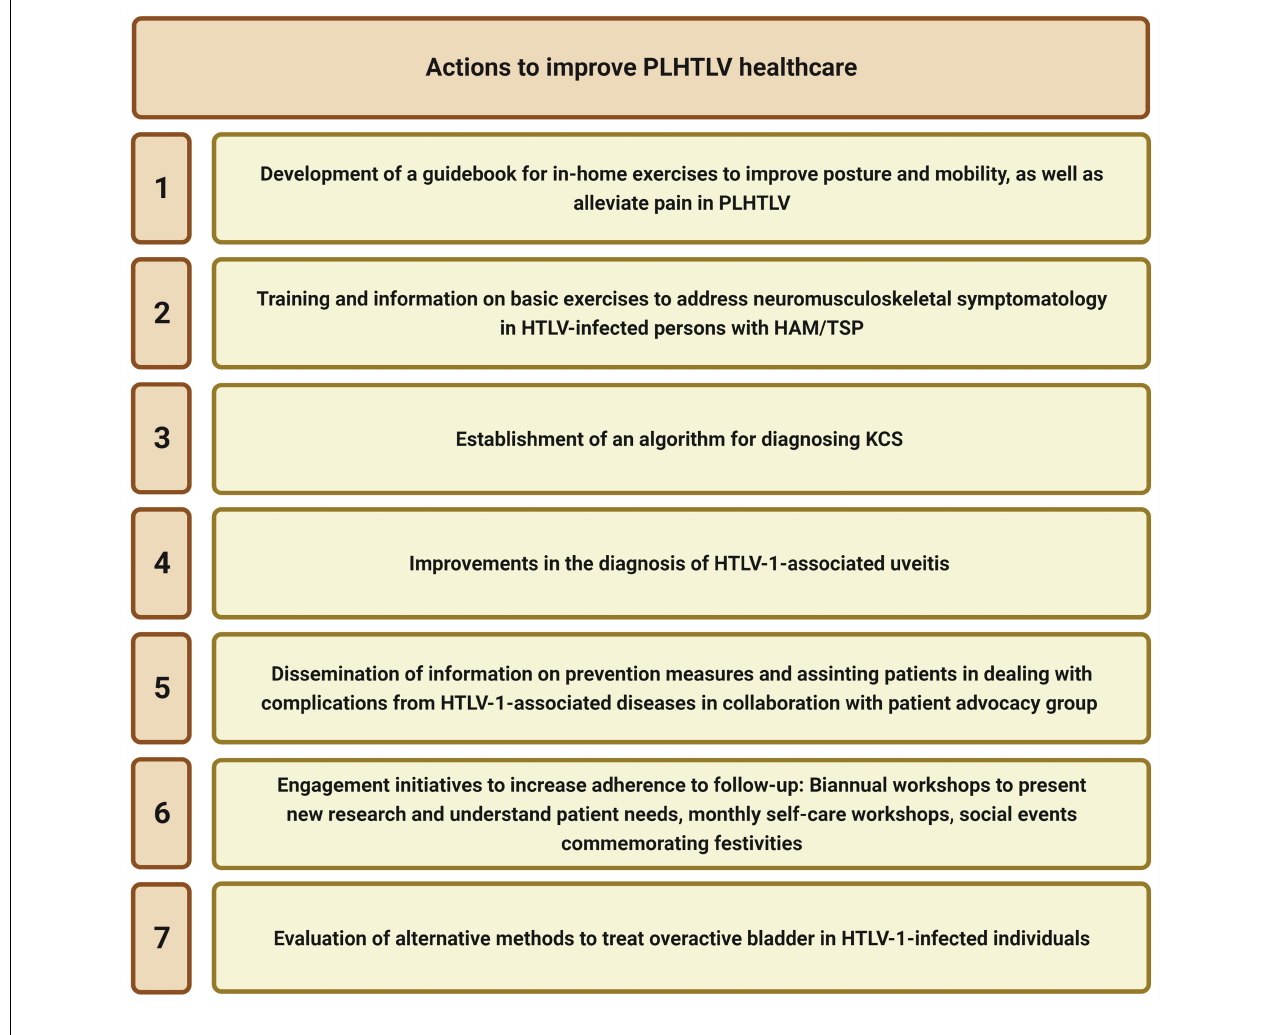
FIGURE 4 | Measures taken by CHTLV to control infection and minimize PLHTLV suffering. PLHTLV, people living with human T-cell lymphotropic virus; CHTLV, Integrative Multidisciplinary HTLV